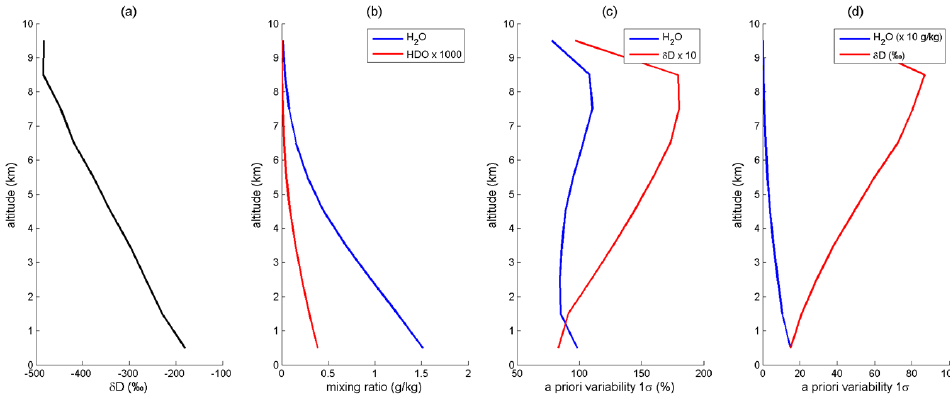
Figure 3. A priori profiles used in the retrieval for δ D in ‰ (a) , for H 2 O and HDO (in gkg − 1 ), plotted in blue and red curves, respectively (b) . The a priori variability 1 σ for H 2 O and δ D are expressed in % (c) and in their respective unit – ingkg − 1 for H 2 O and in ‰ for δ D (d) .